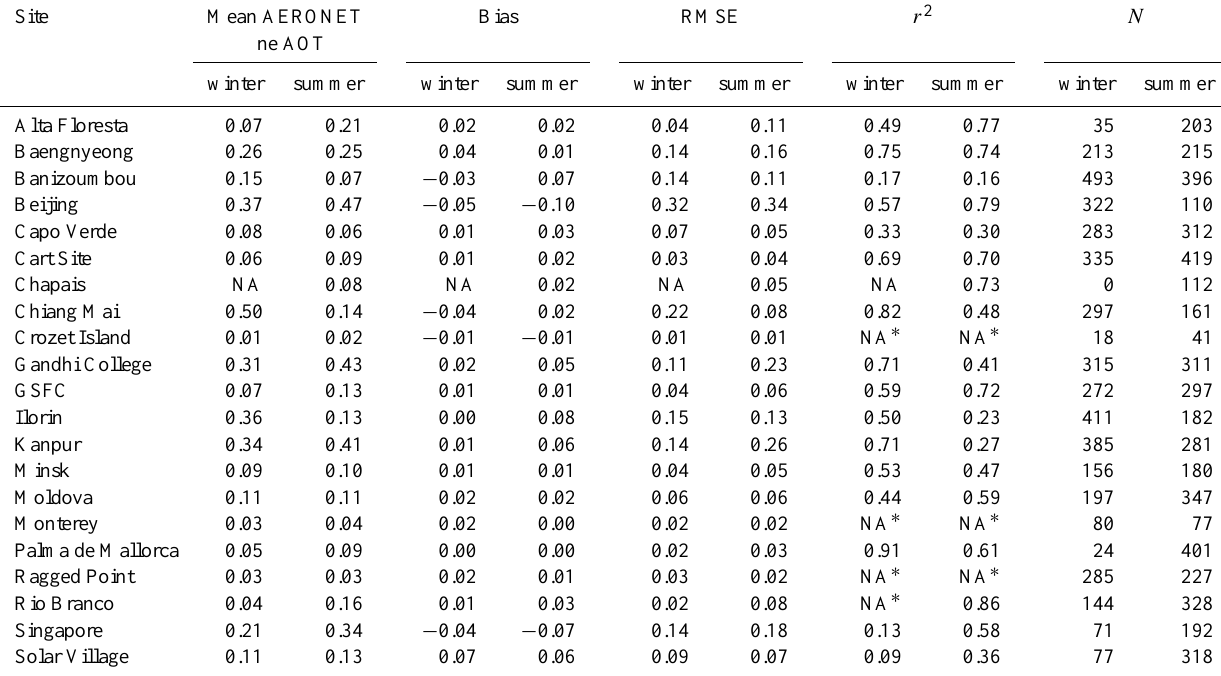
Table 3. Same as Table 2, except for fine-mode AOT at 550nm.